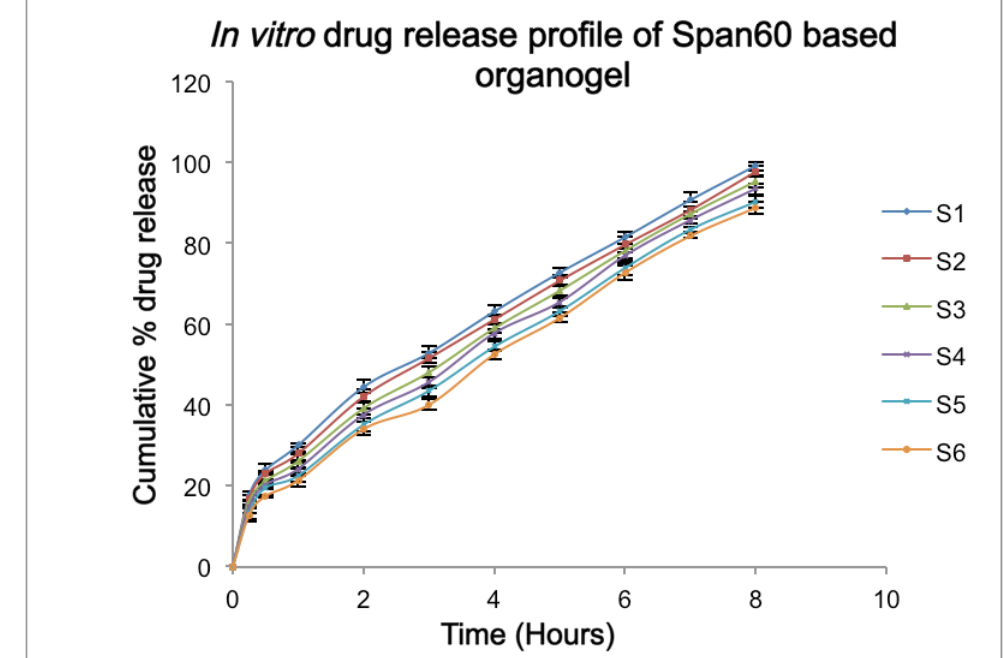
FIGURE 8 - Drug release profile of span 60 based organogel in phosphate buffer of pH 7.4 as a function of